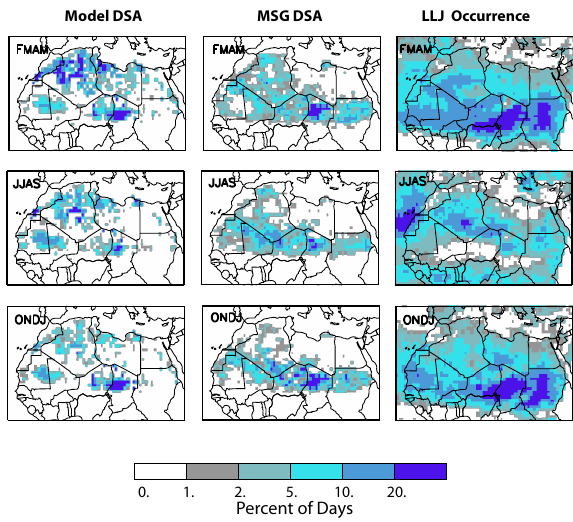
Fig. 2. Distribution of the percent of days when dust source activa- tion occurs in the COSMO-MUSCAT model simulations (left pan- els) and derived from the MSG infrared dust index (middle panels). Right panels: occurrence of nocturnal low level jets in the COSMO model simulations. Results are average values for the years 2007 and 2008, averaged for the months February to May (top panels), June to September (middle panels) and October to January (bottom panels). The model results are binned into 1 ◦ × 1 ◦ grid cells to fa- cilitate comparison with the MSG data.